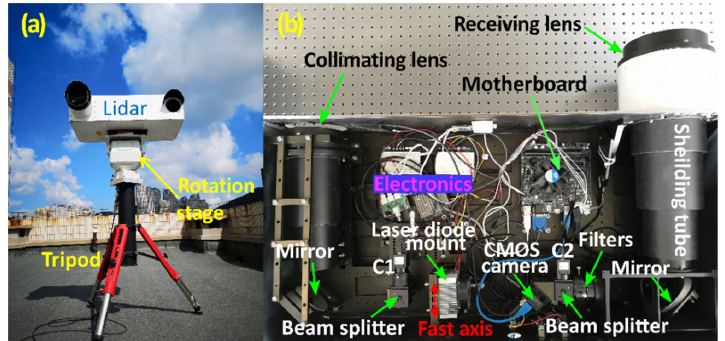
Figure 2. The portable unmanned Scheimpflug lidar system ( a ) system picture, the system was placed on the 7 th floor balcony of an education building in Dalian University of Technology, ( b ) system layout, the double-end arrow indicates the fast axis of the laser